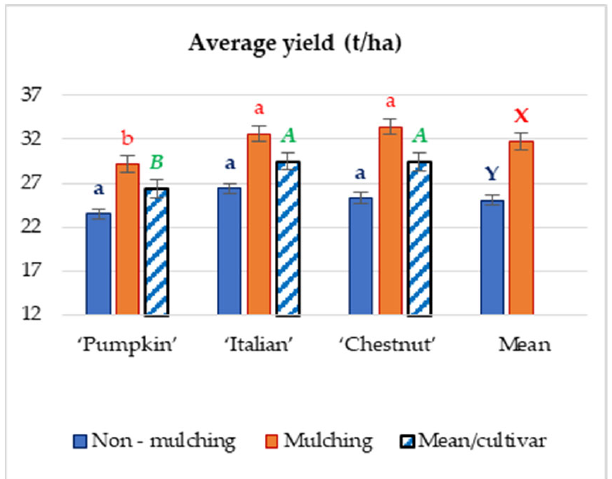
Figure 2. Effect of the cultivar on the production parameters of marketable sweet potato tubers; average yield (t/ha). Bars represent standard error. Means followed by same letter are not significantly different (Tukey’s multiple range test, p < 0.05). Table 2. The effect of cultivar on the production parameters of the sweet